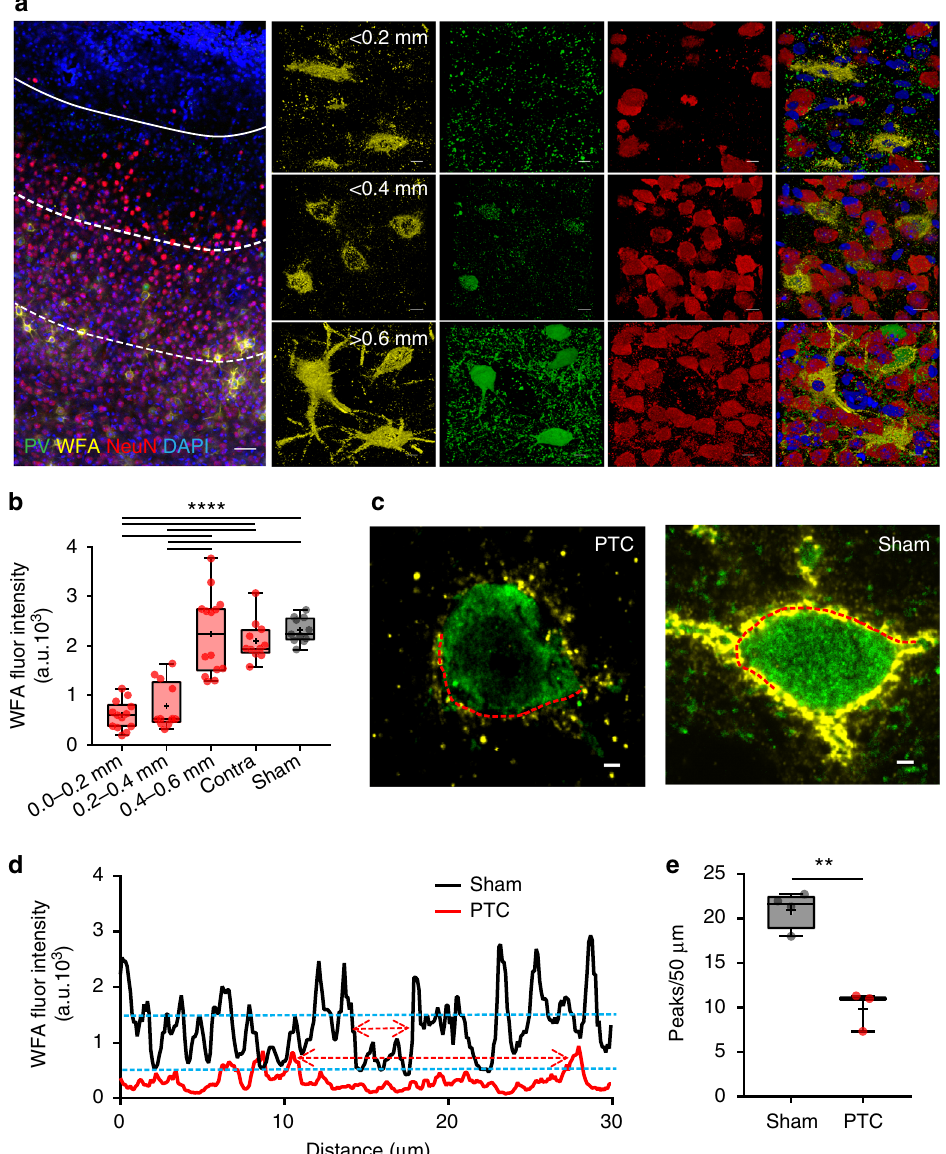
Fig. 2 Disintegration of PNNs in the peritumoral cortex. a Confocal images of GBM22 PTC labeled with DAPI (blue), WFA (yellow), PV (green), and NeuN (red) showing spatial gradient of alterations. The distance between tumor border (white solid line) and each of the dotted lines is ~0.2 mm. Top panel images from <0.2 mm PTC show disintegrated PNNs (yellow) mostly lacking PV and NeuN and reduced neuronal cell numbers in close proximity of tumor. Middle panel images, in the 0.2 – 0.4 mm PTC, show a much higher number of NeuN + neurons but few that contain PV. Bottom panel images from >0.6 mm PTC show mostly intact PNNs around PV neurons and high neuronal cell density (scale = 50 µ m and 5 µ m in large image and panel images, respectively) which are indistinguishable from sham (Supplementary Figure 1a-b). b WFA intensity within 0.0 – 0.2 mm (599.8 ± 80.84 au) and 0.2 – 0.4 mm (776.7 ± 134.8 au) PTC was signi fi cantly lower than sham (2315.0 ± 76.28 au) and contralateral (2012 ± 121.6 au). n = 6 mice. **** P < 0.0001, one-way ANOVA, Tukey ’ s post-hoc test. c Confocal images of two representative PV neurons showing disintegrated architecture in GBM22 PTC compared to sham. Scale = 2 µ m. d WFA fl uorescence intensity of a line drawn along the periphery of PV neuron in the PTC (left in c ) and sham (right in c ) showing many high-intensity WFA peaks in sham compared to the PTC. Upper and lower blue dotted lines represent the threshold WFA intensity (50% of the highest intensity) for the PTC and sham, respectively. Upper and lower red two-headed arrows within two nearest WFA peaks indicate the size of a hole in PNN from the PTC and sham, respectively. e Disintegrated PNNs in the PTC show signi fi cantly lower numbers of WFA intensity peaks (sham, 21.15 ± 0.92, n = 13 PNNs from four mice; PTC, 9.88 ± 0.84, n = 9 PNNs from three mice). ** p < 0.01, unpaired t test. PTC in ( d ) and ( e ) represent 0 – 0.4 mm (>0.6 mm) PTC (Fig. 4a (top square), 4b, c). Secondly, PNNs are peritumoral PNN degradation. However, three lines of reasoning suggest otherwise. Firstly, while the PTC in close proximity to the tumor (<0.3 mm) showed disintegrated PNNs surrounded by mouse (Fig. 4d − g, Supplementary Fig. 1e), which is a genetic highly reactive astrocytes (Fig. 4a (bottom square), Fig. 4b, c), we model of astrogliosis and spontaneous seizures 31 . Thirdly, peri- observed essentially intact PNNs around equally high GFAP (glial tumoral reactive astrocytes did not show detectable MMPs/gela- fi brillary acidic protein) expressing astrocytes in more distal tinase activity (Supplementary Fig. 2a).